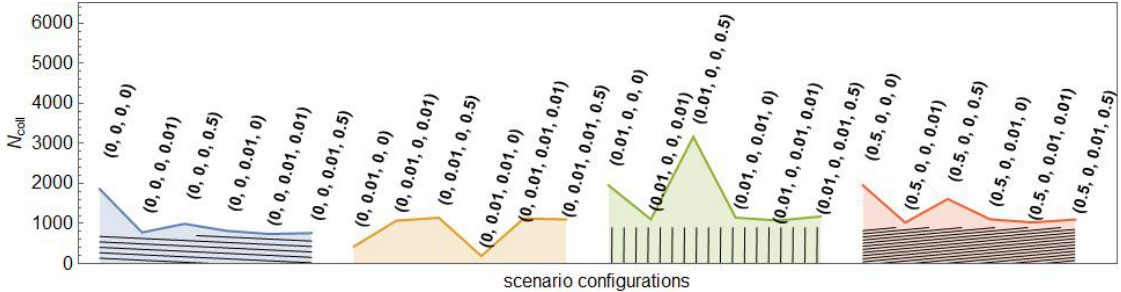
Figure 8. Number of collected items for a selected set of 24 scenario configurations a in CCM. The data labels show the corresponding cue values of a = ( s e , i e , i r , s r )